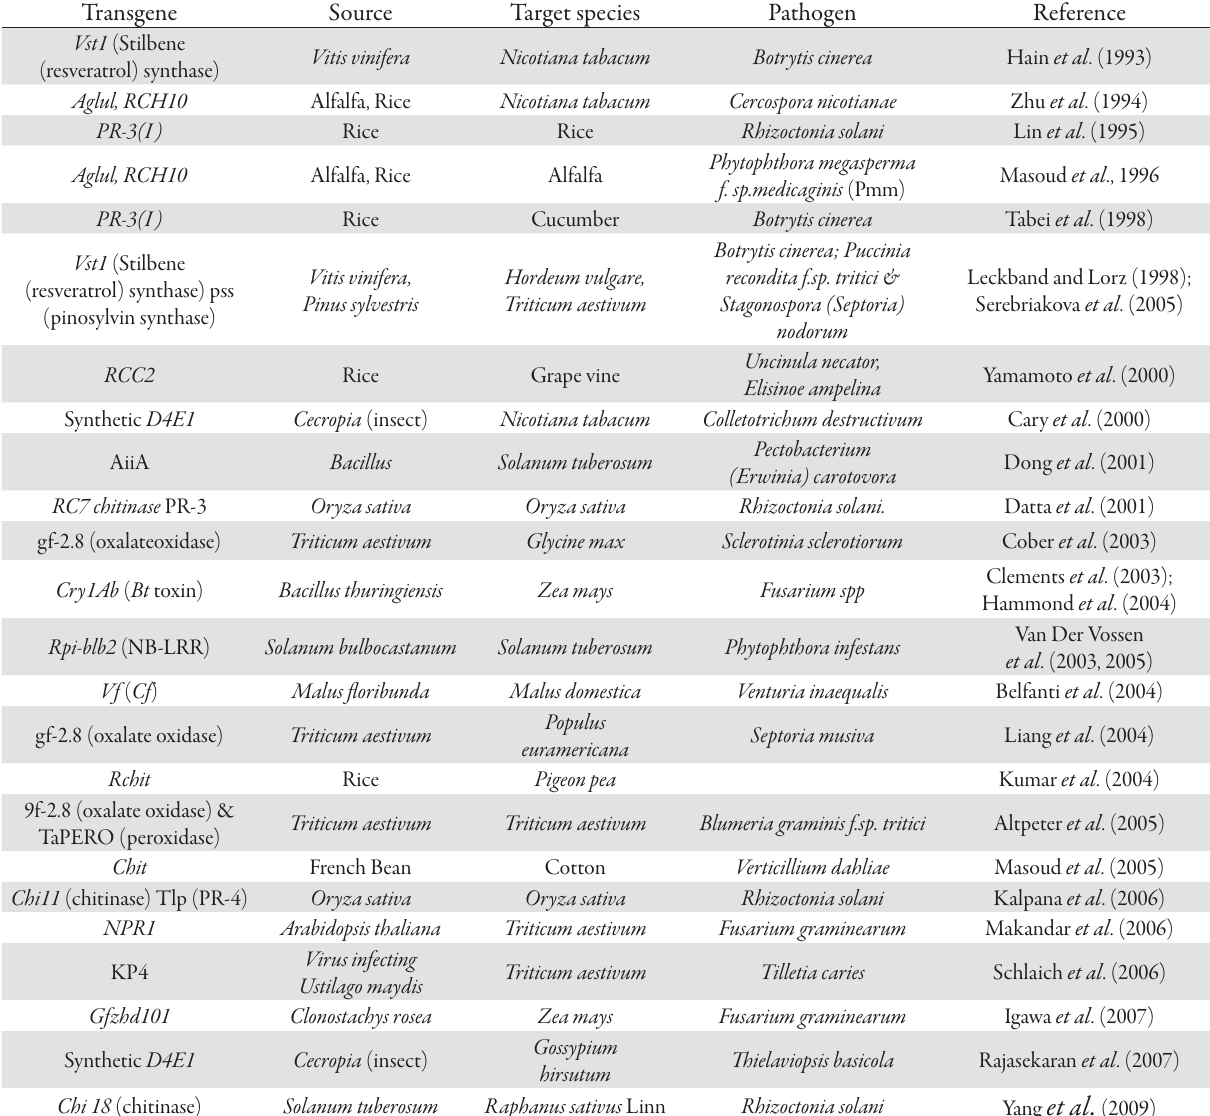
Tab. 1. Transgenic plants for fungal disease resistance